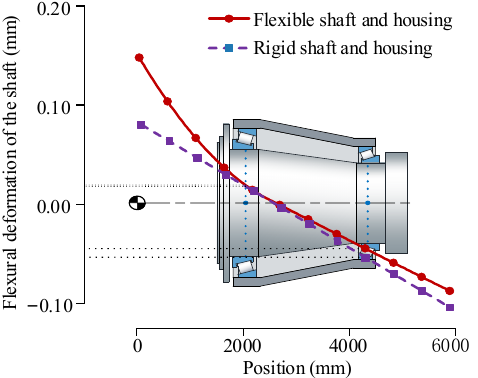
Figure 19. Comparison of shaft deformation under rigid and flexible structure.